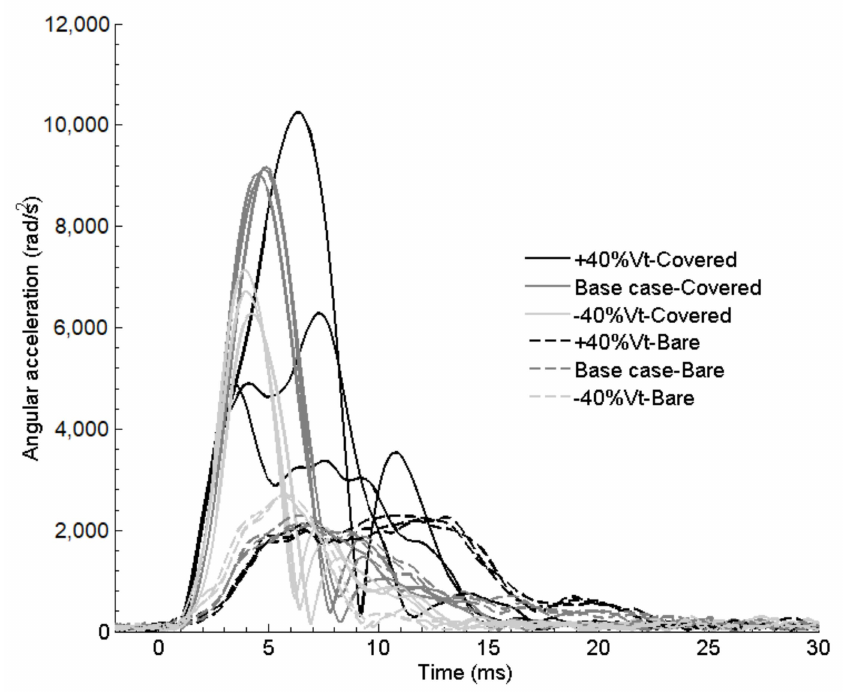
Figure 5. Resultant angular acceleration for the front impacts. Solid lines correspond to covered headform and dashed lines correspond to bare headform